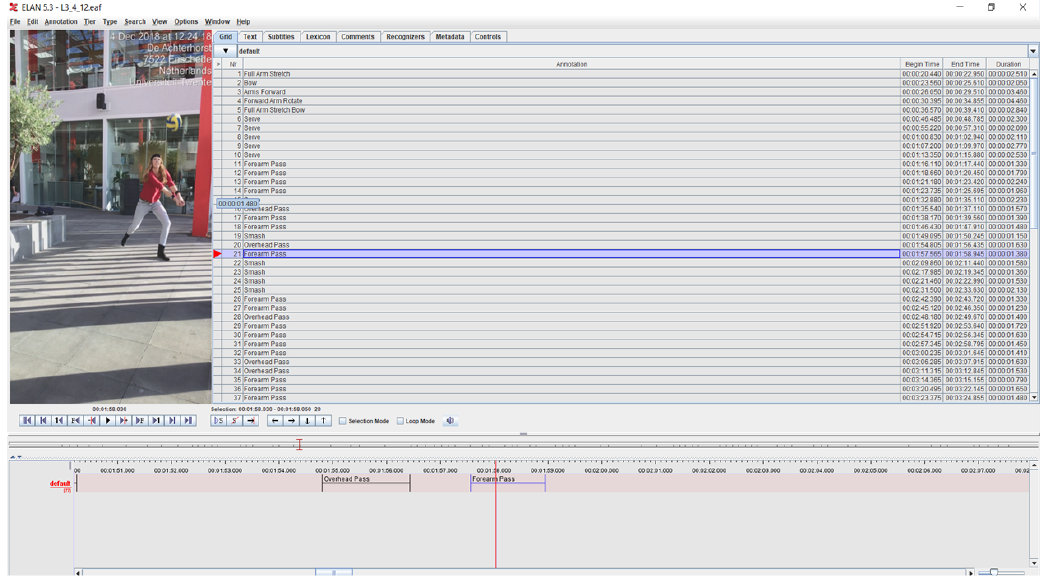
Figure 2. Annotation example with Elan annotation tool [28].